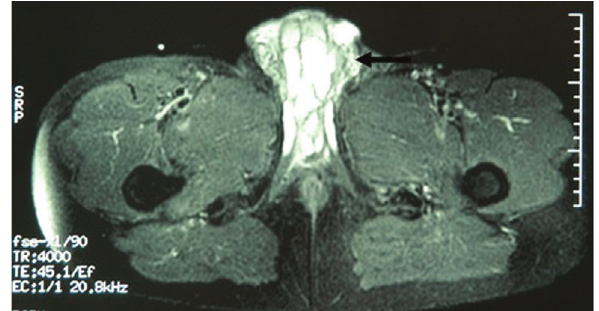
figure 2 - Massively dilated draining vein indicative of the presence of an arteriovenous shunt